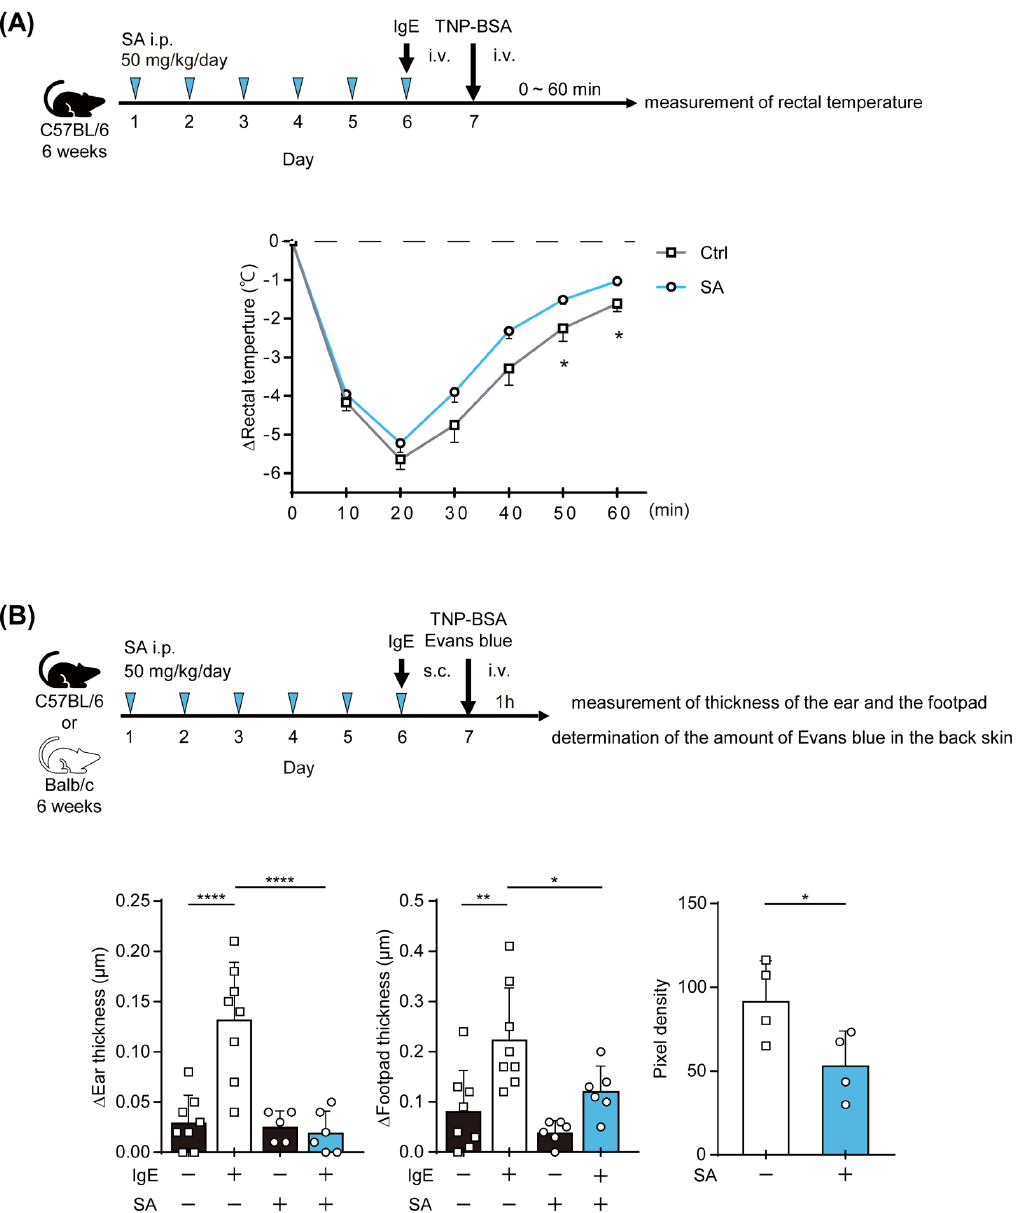
Figure 4. The administration of salicylaldehyde alleviated the IgE-induced anaphylactic reaction. Effects of the administration of salicylaldehyde on PSA ( A ) and PCA ( B ). Mice were intraperitonially (i.p.) administered 50 mg/kg/day salicylaldehyde (SA) or saline (Ctrl) once a day for 6 days prior to the anaphylactic reaction ( A , B ). ( A ) Changes in the body temperature of control and salicylaldehyde-treated mice following PSA. Open square, control ( n = 8); open circle, administration of salicylaldehyde ( n = 9). The t -test was used for statistical analyses. *, p < 0.05 vs. control. ( B ) Thicknesses of the ear (left panel) and footpad (center panel) of saline-treated (SA − ; n = 8) or salicylaldehyde-treated (SA+; n = 6) mice 1 h after the injection with TNP-BSA. Each individual was s.c. injected with IgE (IgE+) on the right ear or right footpad and s.c. injected with saline (IgE − ) on the left ear, or left footpad. The amount of Evans blue in the back skin of control (SA − ; n = 4) or salicylaldehyde-treated (SA+; n = 4) Balb/c mice 1 h after the injection of TNP-BSA (right panel). Dunnett’s multiple comparison test (ear thickness and footpad thickness) and the t -test (Evans blue) were used. *, p < 0.05; **, p < 0.01; ****, p < 0.0001.